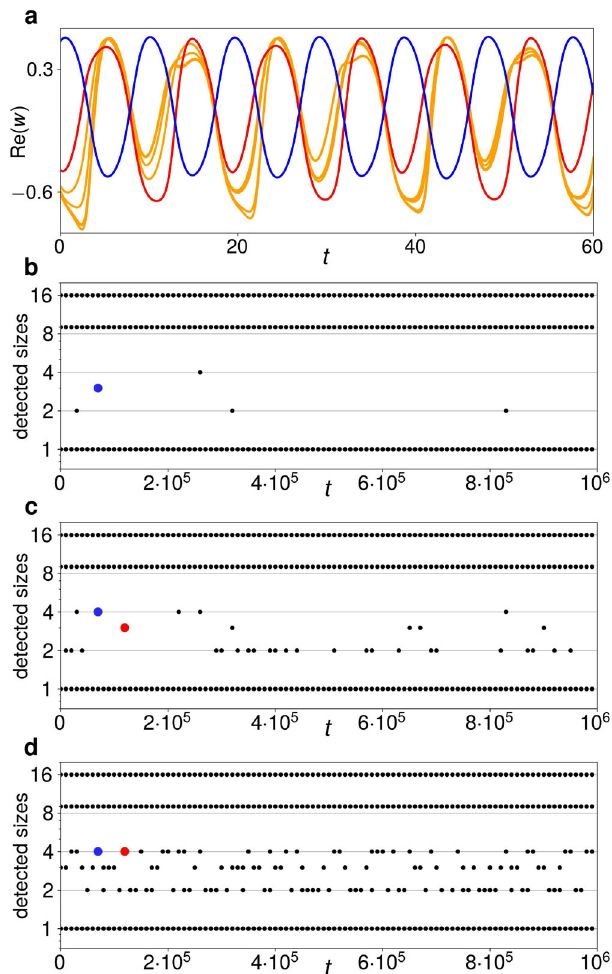
Fig. 5 Partially clustered 16 − 9 − (7 × 1) solution past the cascade in Fig. 3c. a Time series of Re ð w k Þ for c 2 = − 0.712 and η = 0.63. The single oscillators (yellow) reach a deep minimum approximately when the cluster of nine (red) reaches a shallow minimum and the cluster of 16 (blue) reaches a maximum. b – d Cluster sizes detected when two oscillators are said to be clustered if their cross-correlation over an interval of 800 time units is > 1 − ε for ε = 10 − 8 , 10 − 4 and 10 − 2 , respectively. The large red and blue dots mark two exemplary loose oscillator conglomerations at different sensitivities ε